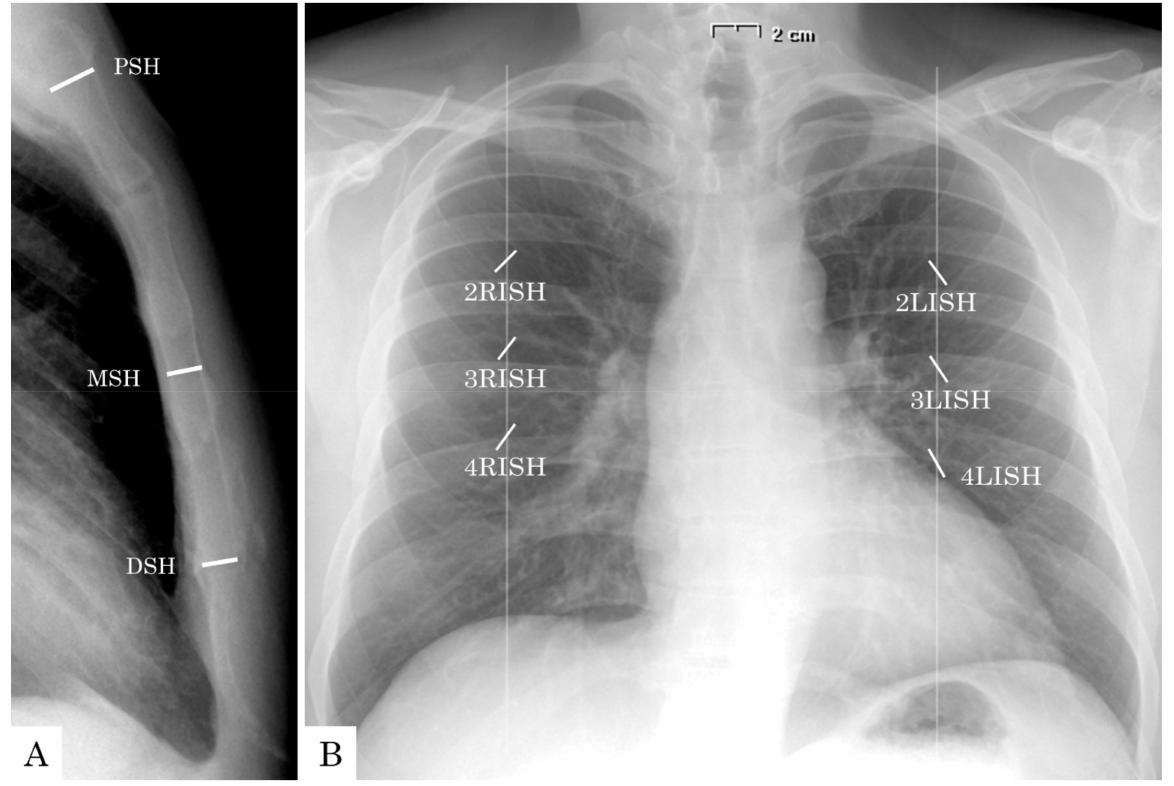
Figure 1. Perioperative measurements at chest X-ray. ( A ) PSH: proximal sternal height; DSH: distal sternal height; MSH: midsternal height. ( B ) 2LISH: 2nd left intercostal space height; 3LISH: 3rd left intercostal space height; 4LISH: 4th left intercostal space height; 2RISH: 2nd right intercostal space height; 3RISH: 3rd right intercostal space height; 4RISH: 4th right intercostal space